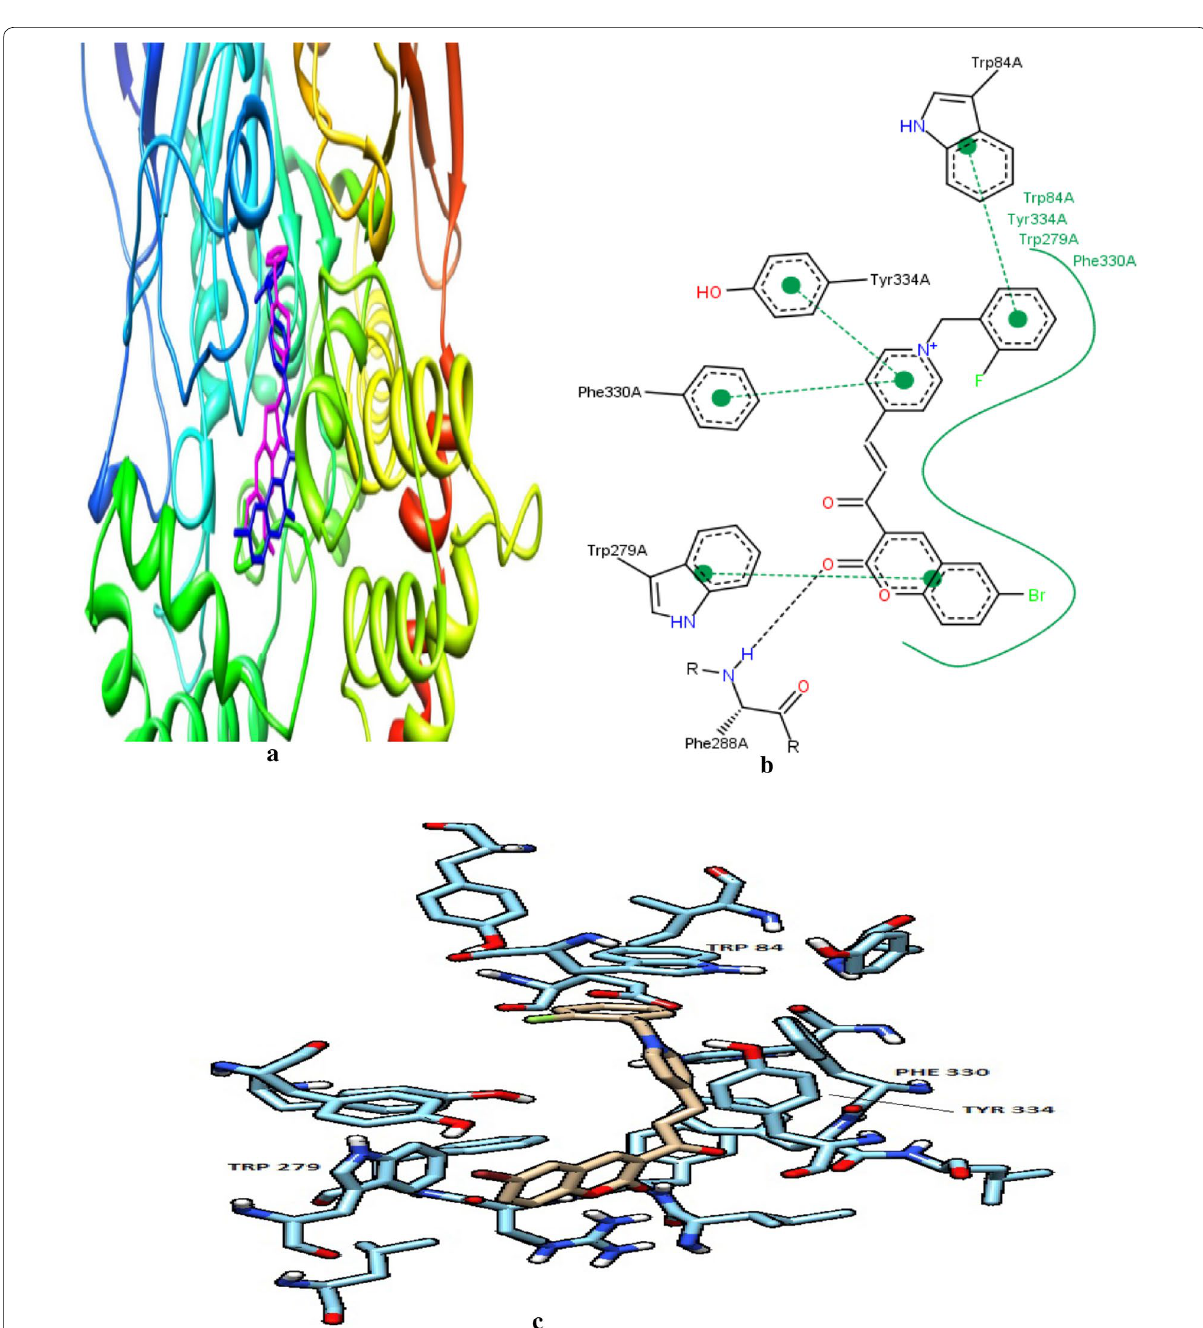
Fig. 22 a Superimposition of C15a (blue) and donepezil (magenta) in the gorge of TcAChE. b 2D representation of binding mode of C15a and amino acid residues in the gorge of TcAChE created by PoseView. c Docking of C15a in the active site of TcAChE